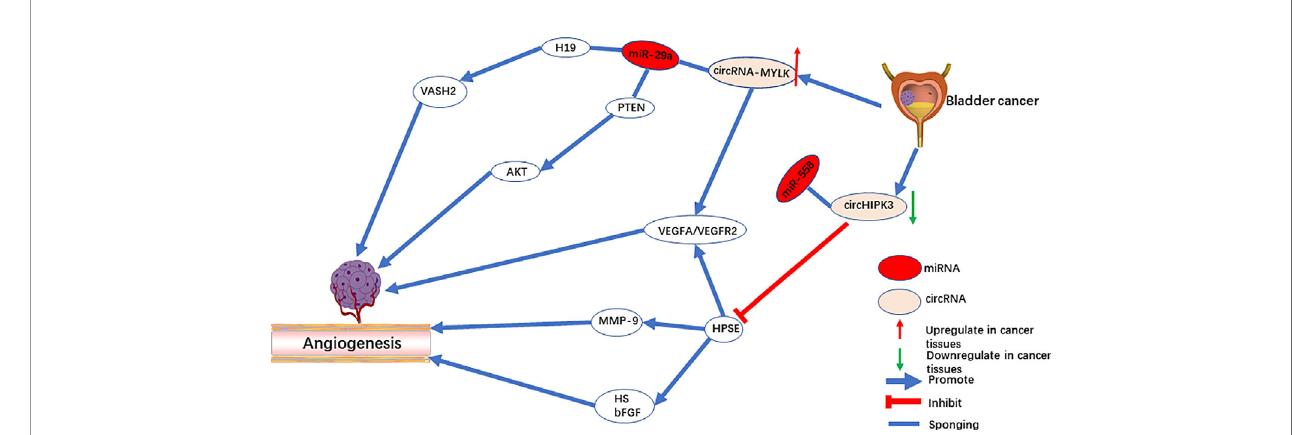
FIGURE 1 | The role of circRNAs in pro-angiogenesis and anti-angiogenesis in bladder